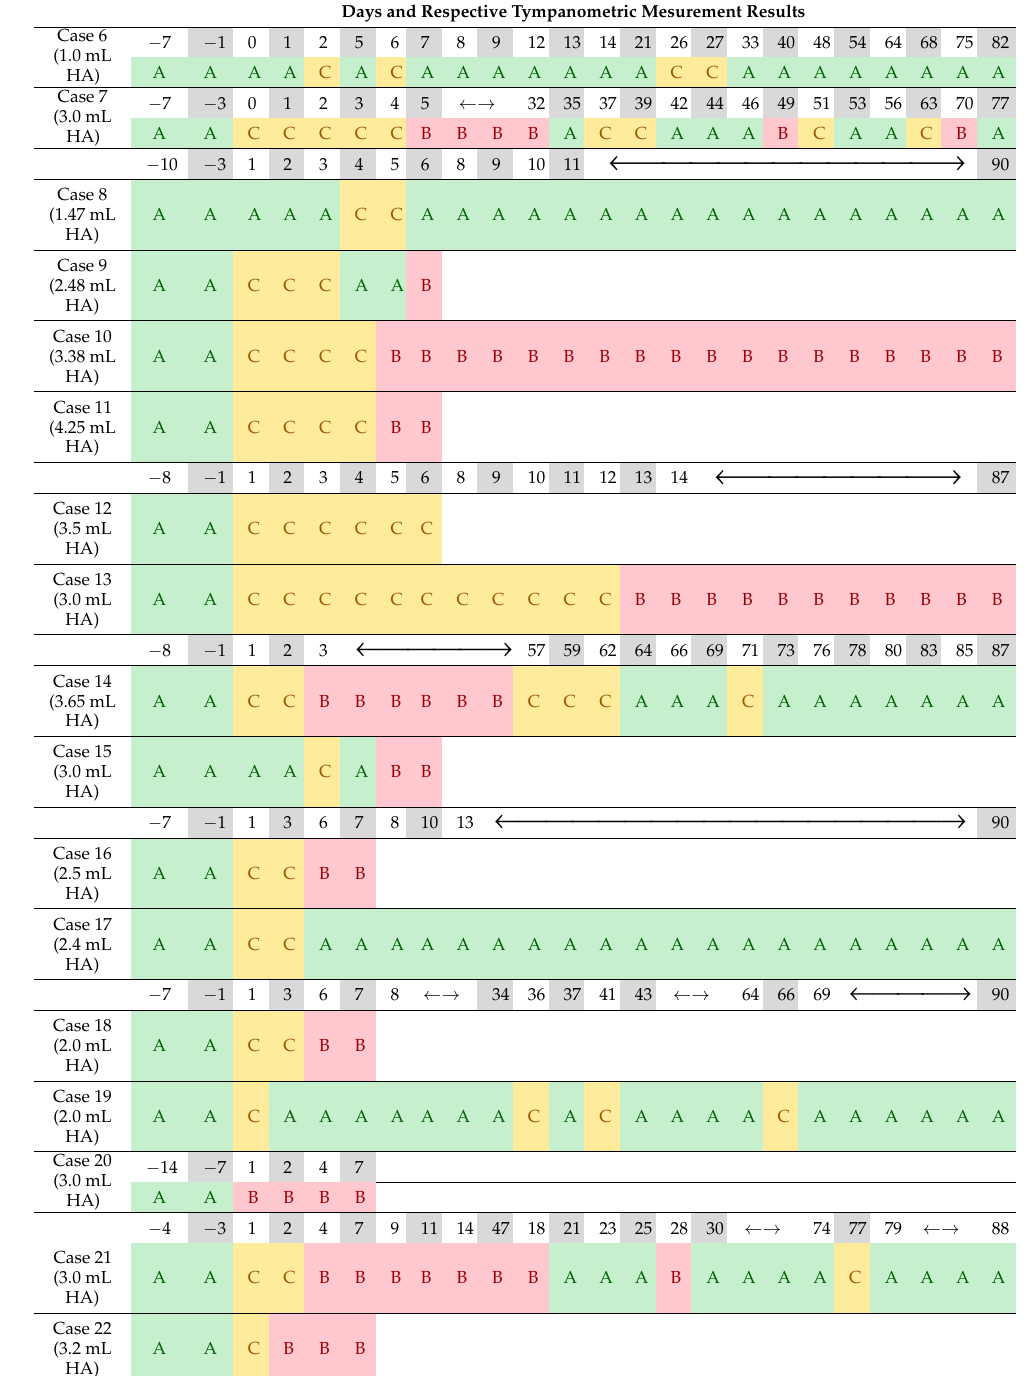
Table 5. Results of tympanometric measurements over the experimental period after injection of stabilized HA. Days and Respective Tympanometric Mesurement Results